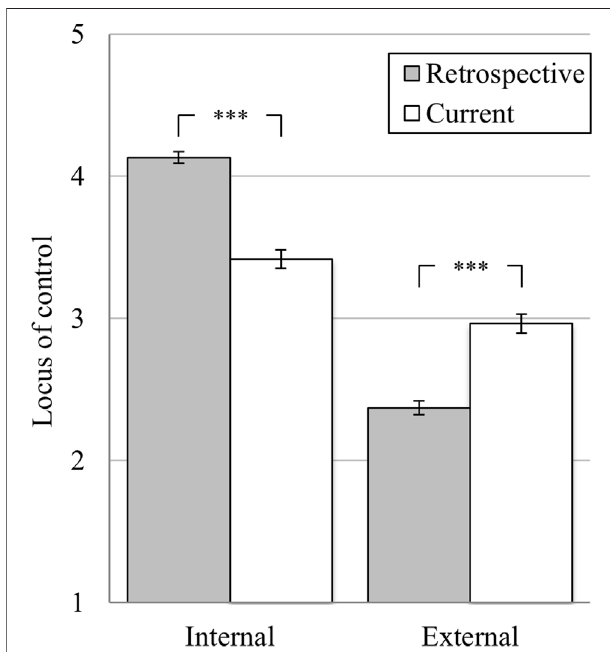
FIGURE 1 | Change in internal and external locus of control. Notes: * p < 0.05; ** p < 0.01; *** p < 0.001; means with 95% con fi dence intervals (1 (cid:1) “ strongly disagree ” 5 (cid:1) “ strongly agree ” ); retrospective (cid:1) retrospective rating related to a pre-pandemic time-point; current (cid:1) assessment at the current time point (February/March 2021). N (cid:1) 727.